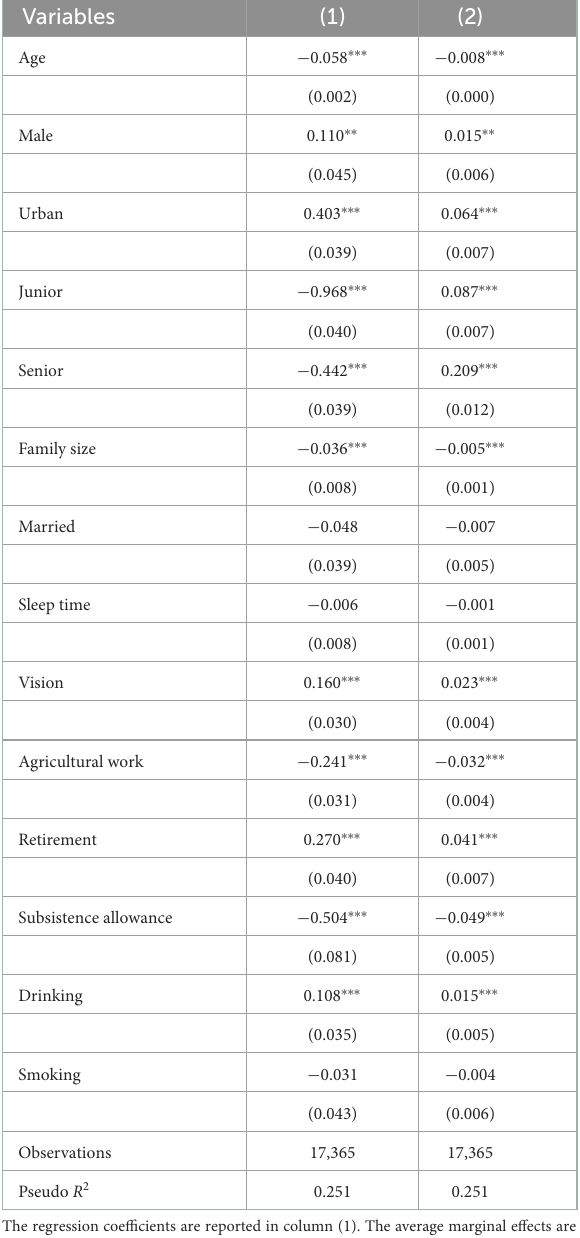
TABLE 3 Determinants of the elderly’s choice of internet use.